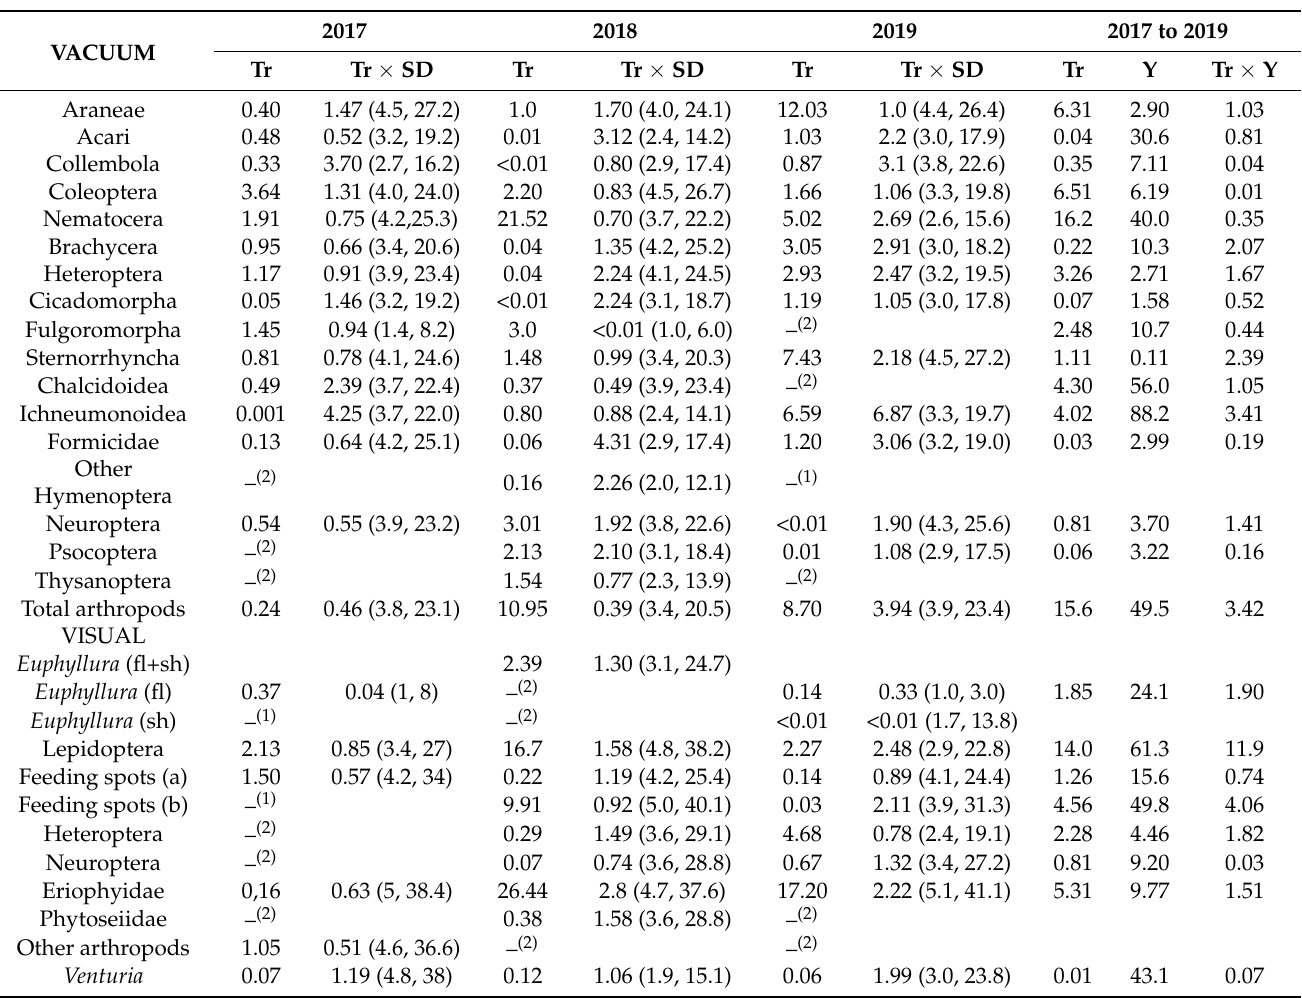
Table A3. Results of the repeated-measures ANOVA for the three years of study showing the F statistics of the irrigation treatment (Tr) and interaction Treatment × Sampling Date (Tr × SD) for the most important variables registered in the visual and vacuum sampling methods for 2017 to